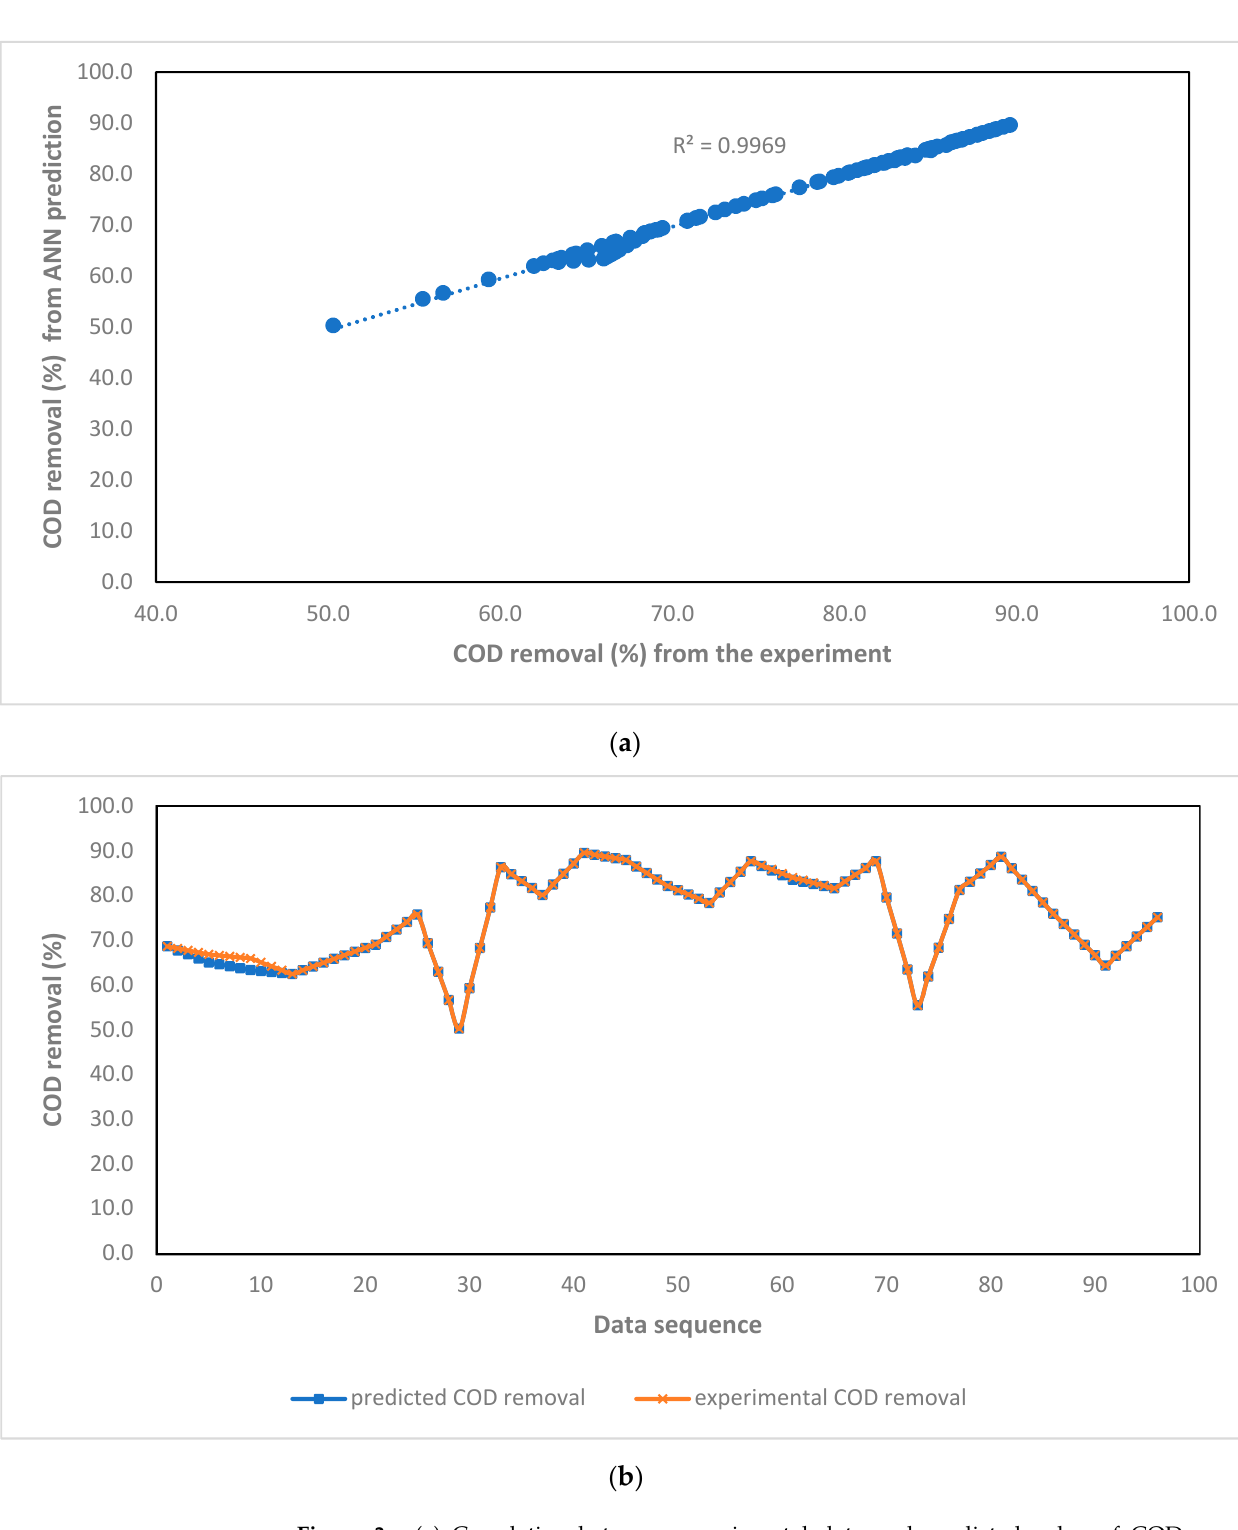
Figure 3. ( a ) Correlation between experimental data and predicted value of COD removal. ( b ) Prediction value and measured data by ANN model for COD removal of anaerobic digestion. The R value for predicting the value of methane purity for each hidden neuron can be found in Table A11. The R 2 value obtained from the BR trained ANN model with 12 hidden neurons is 0.972 (Figure 4a), which is slightly lower than the R 2 = 0.985 achieved by Yu, Jaroenpoj and Griffith [51] using 5 input neurons with 8 hidden neurons. Similar to COD removal, the predicted value obtained from the ANN model and experimental value of methane purity has slight deviation only (Figure 4b).